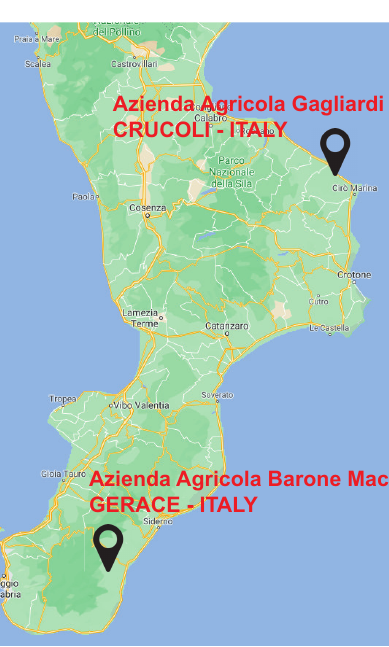
Figure 12. Web platform: dashboard ( a ), data overview and analysis ( b ) and NDVI computing and evaluation ( c ) pages.